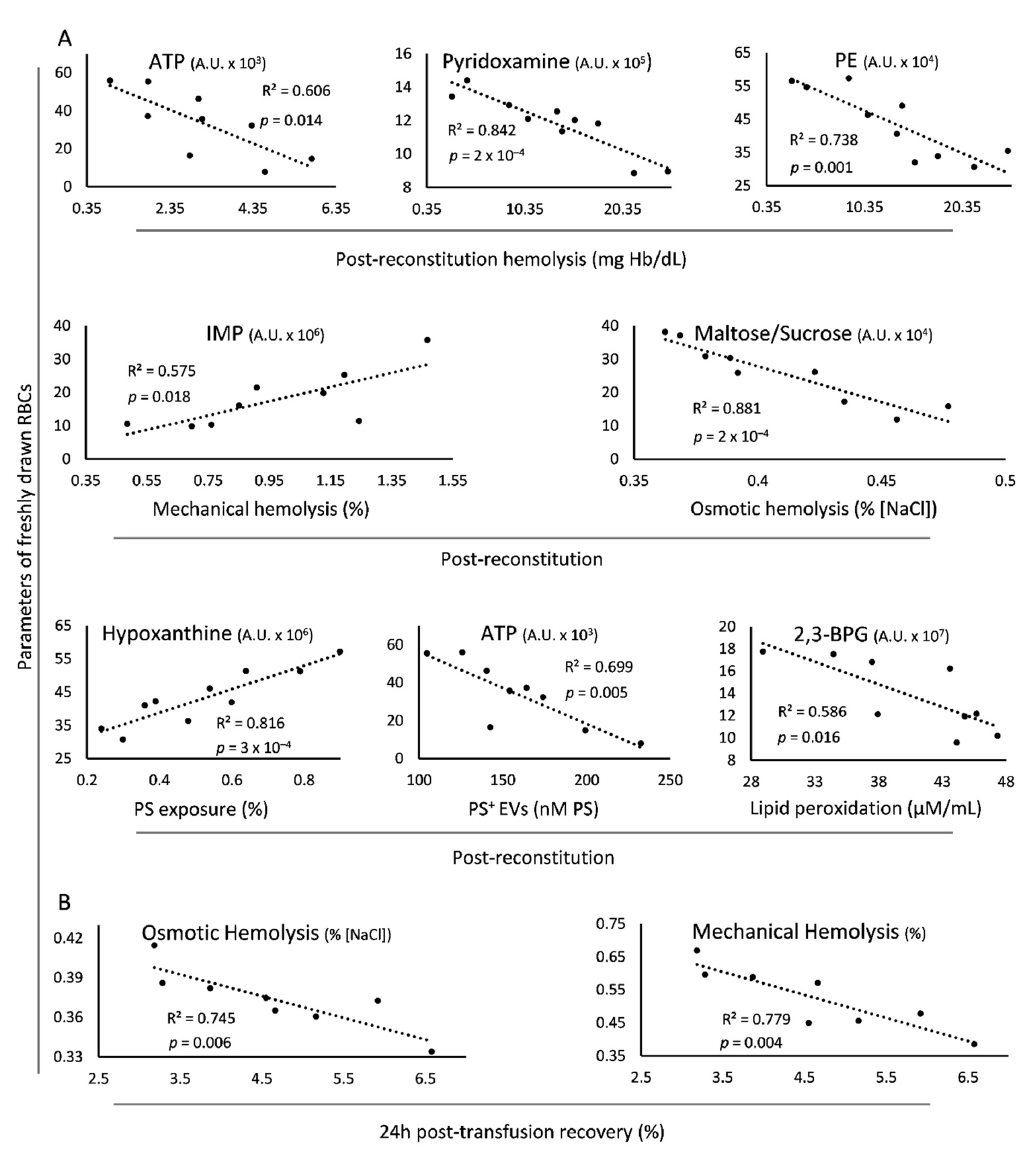
Figure 5. Statistically significant correlations of parameters of freshly drawn blood with the post- reconstitution physiology and 24 h recovery of beta-thalassemia trait ( β Thal + ) donated RBCs. ( A ) Baseline levels of metabolites correlating with physiological parameters of reconstituted RBCs. ( B ) Baseline fragility indices correlating with post-transfusion recovery in mice. The selected scatter- plots concern late storage, thalassemic plasma ( A ) and C57BL/6J mice ( B ), but significant connec- tions (with slightly different R 2 values) were evident at every condition tested (i.e., early/late storage, control/thalassemic plasma, immunodeficient/sufficient mice), with the exception of ATP and he- molysis, a correlation evident only in early storage. PE: phosphoethanolamine; 2,3-BPG: 2,3- bisphosphoglycerate; PS: phosphatidylserine; EVs: extracellular vesicles.